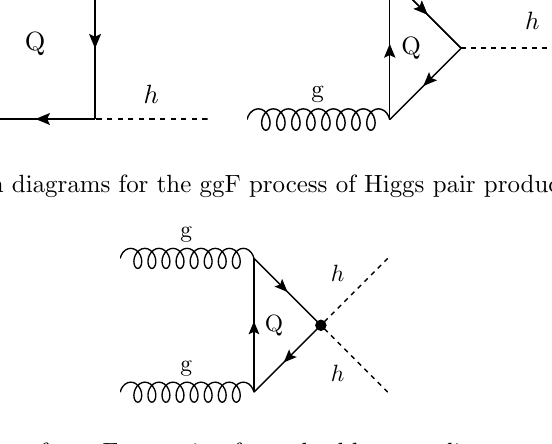
Figure 3 . The new diagram for ggF emerging from the hhqq coupling stemming from an e(cid:11)ective dim-6